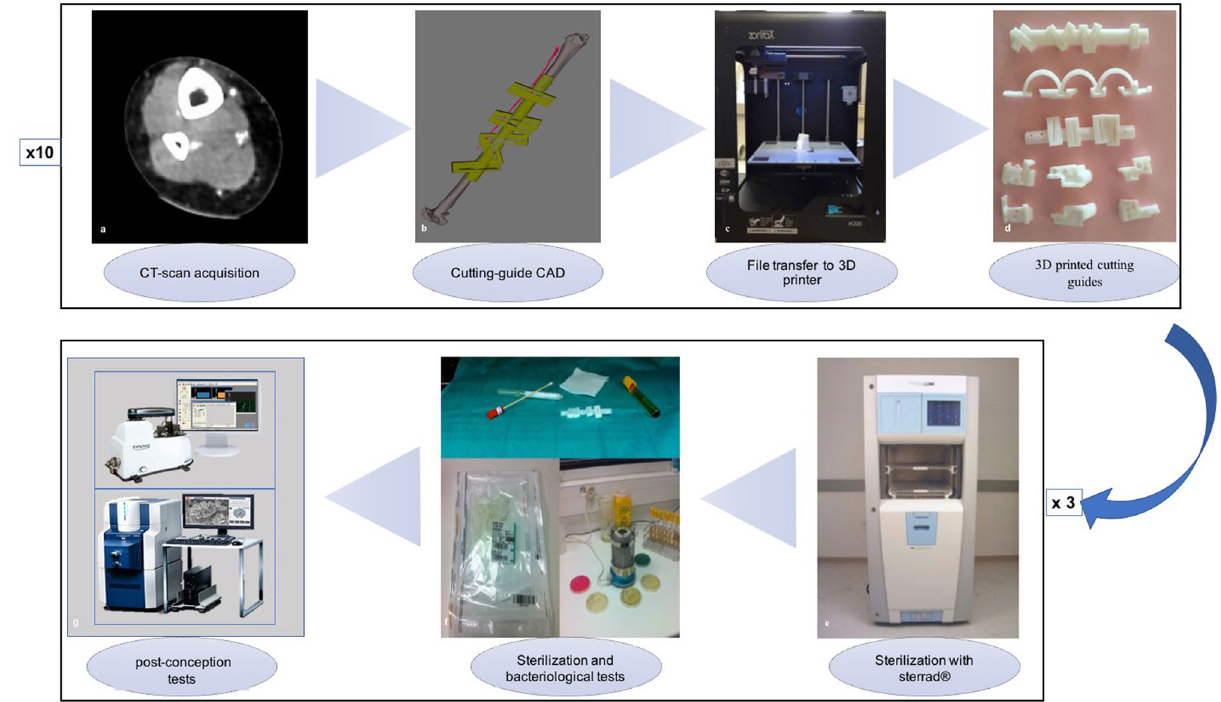
Figure 1. Manufacturing process of the surgical cutting guides with the ABS 3D printer. ( a ) DICOM format images from a CT-scan of the inferior limbs used for the volume rendering and 3D reconstruction, ( b ) Personalized 3D printed guides designed to anatomically fit the fibula and guide the osteotomies in order to have exactly the osseous segments needed for the mandibular reconstruction, and avoiding all important structures as vessels and nerves, ( c ) 3D printer to obtain ABS cutting guides from STL format digital files, ( d ) Cutting guides before sterilization, ( e ) The Sterrad 100NX is a system that allows dry, low